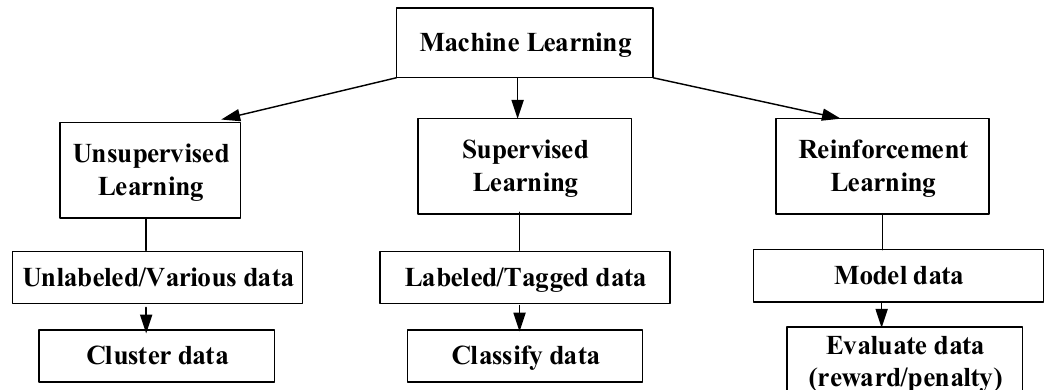
Figure 2. Different machine learning approaches.